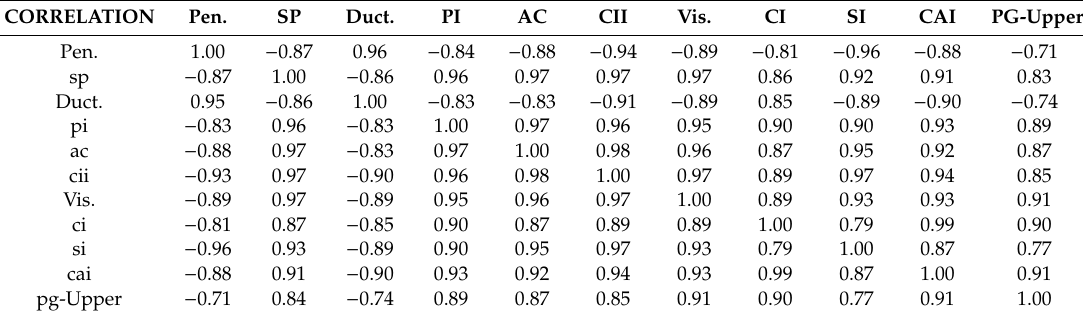
Table 3. Correlation matrix of different parameters of asphalt binders.